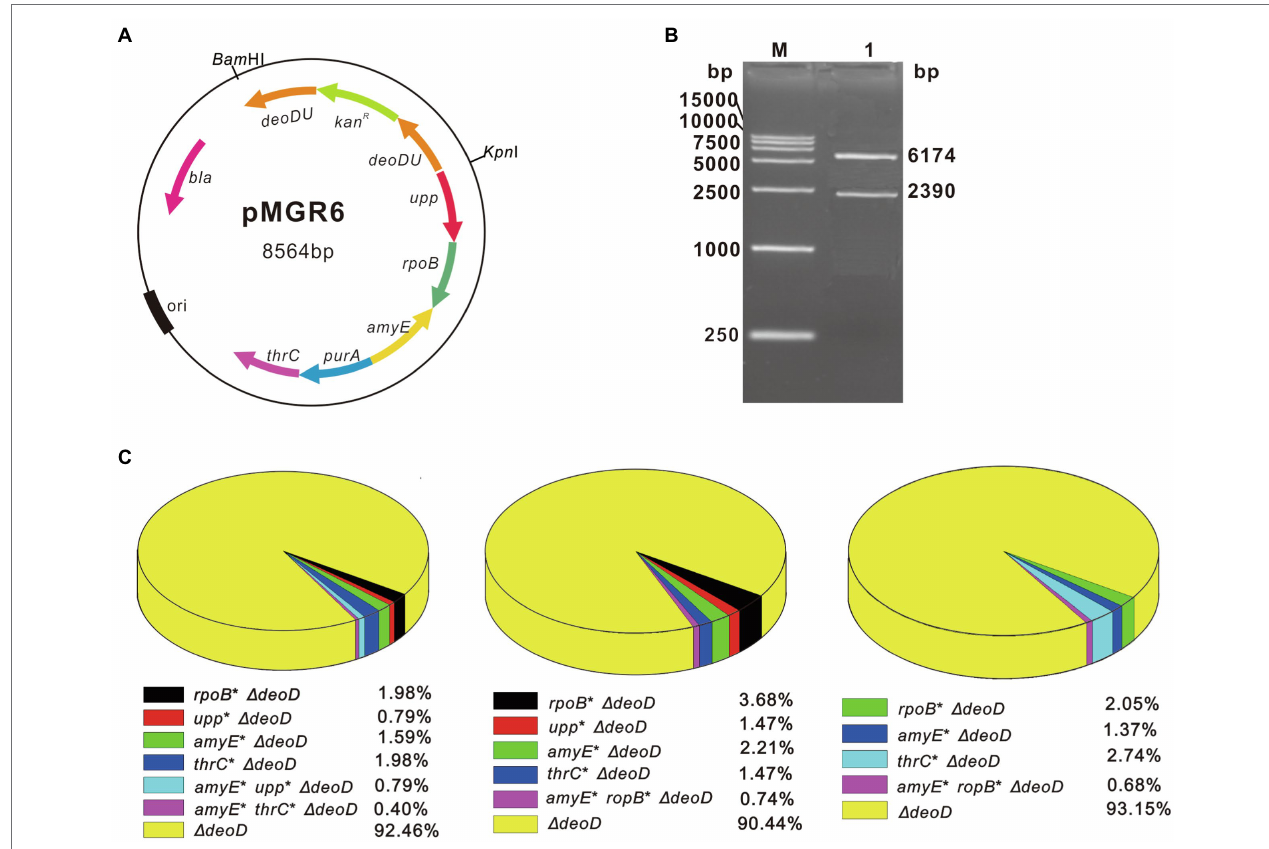
FIGURE 3 | Co-editing frequencies of multiple variants using the SMGE method. (A) The map of the plasmid pMGR6. Homologous arms of six different target genes, upp , ropB , amyE , deoD , purA, and thrC , were inserted into the cloning T vector. (B) The verification of plasmid pMGR6 by digestion with restriction enzymes. The plasmid pMGR6 was verified by digestion with Bam HI and Kpn I. (C) The editing frequencies of three independent transformations of pMGR6. LB plates containing kanamycin (LB-Km) were used to rapidly select various recombinants when deoD was replaced by kan R in the chromosomal